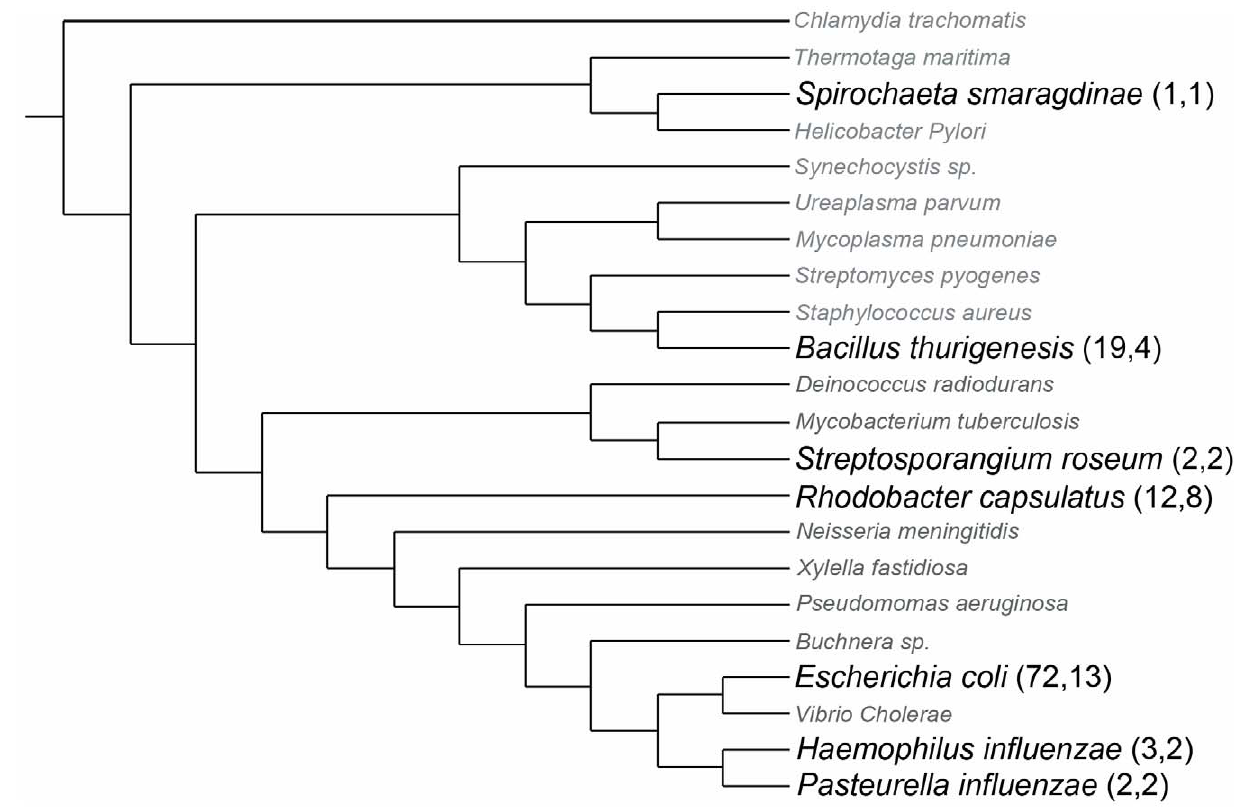
Figure 10. Phylogenetic Distribution of Lsr at different Phylogenetic scales using reconciled LMNAST results. E. coli Lsr system LMNAST hits overlaid onto a bacterial phylogenetic distribution as developed in and adapted from [27]. Each leaf bears a representative member from a larger unseen collapsed branch. The larger, bolded leaves contain Lsr system homologs within the collapsed branch, whereas the grayed italicized leaves do not. Parenthesized numbers indicate the number of strains and species with Lsr system LMNAST hits contained within the collapsed branch.